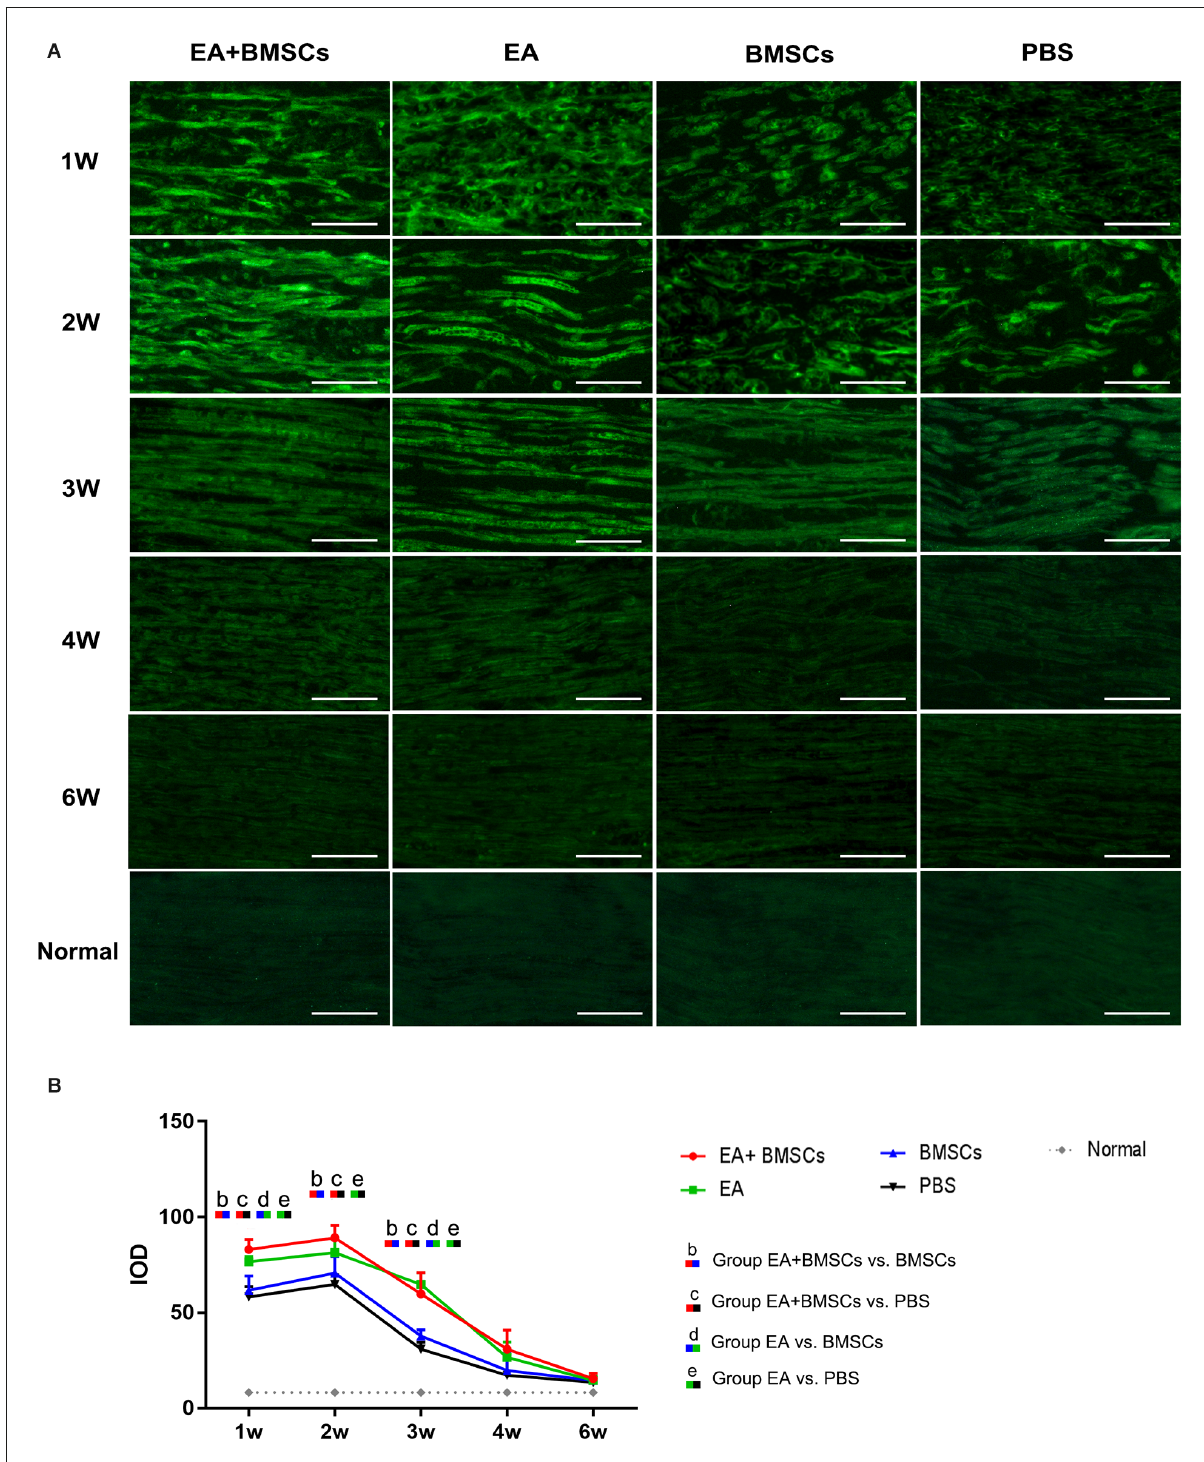
FIGURE6 Histology of netrin-1 expression of the injured nerves. Immunofluorescence staining shows that netrin-1 is present in the myelin sheath composed of Schwann cells, therefore when it is secreted, the myelin sheath is colored and outlined (A) . The expression of netrin-1 of all subgroups significantly increased in 1–2 weeks. The EA+BMSCs and EA subgroups had higher netrin-1 expression (green) than the BMSCs and control subgroups (PBS treatment) in 1–3 weeks (B) . In addition, 4 and 6 week figures had a darker degree of staining with the loss of fiber textures (A) , which could be judged as a negative expression of the netrin-1 protein. Scale bar = 50 µ m; W: week. The IOD of acquisition points within groups were compared by using one-way ANOVA with Bonferroni post-hoc testing, and Table 4 lists statistically significant differences. IOD, integrated optical